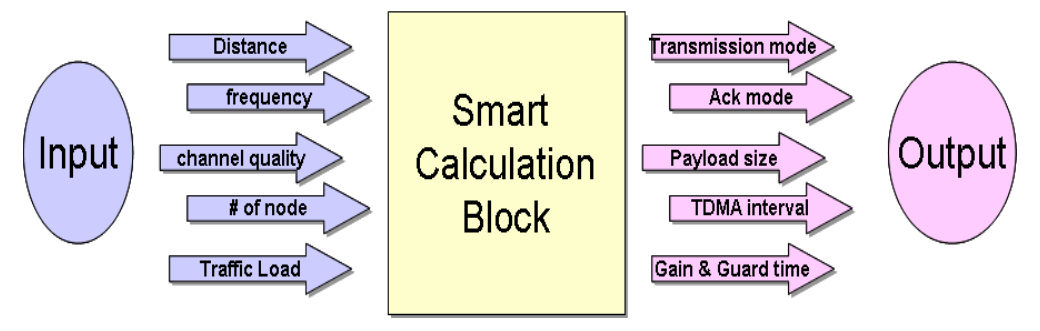
Figure 1. Smart Calculation Block